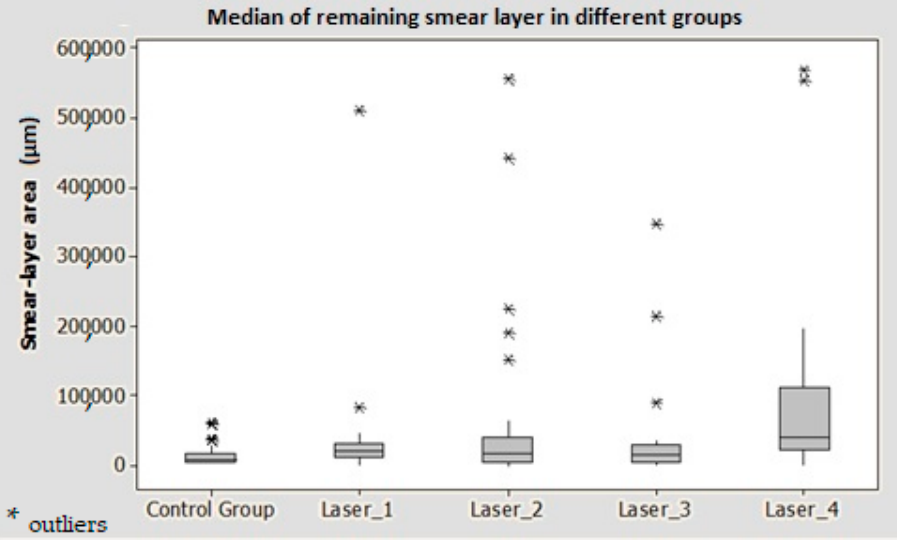
Figure 5. Box plot showing the comparison of the remaining smear layer between control and laser groups.